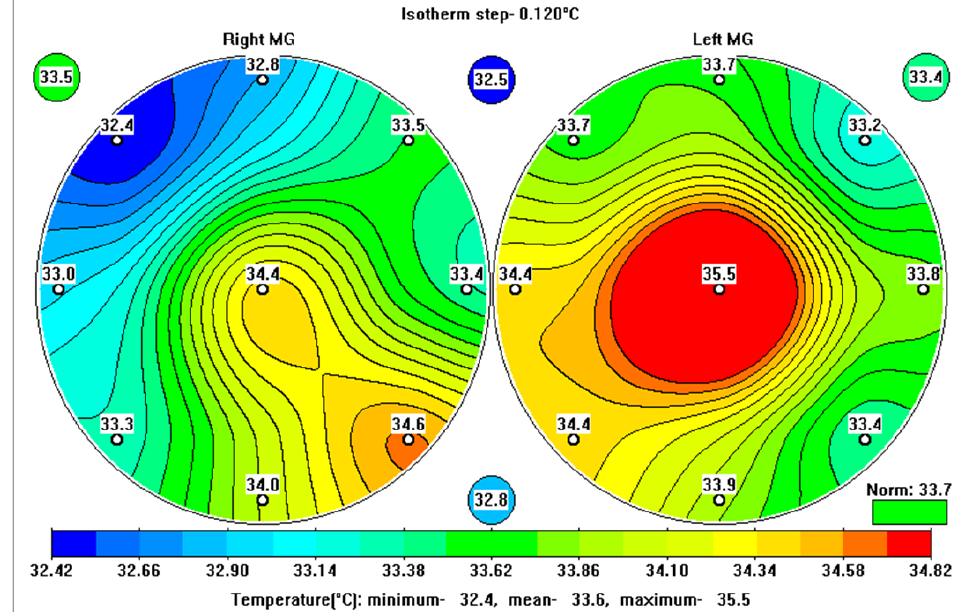
Figure 4. Internal temperature fields in the left ( right ) and right ( left ) mammary glands of an individual at risk of developing breast cancer.